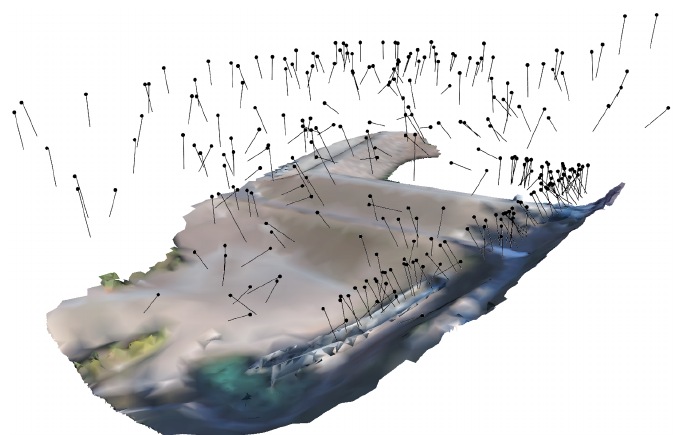
Figure 8. Final optimized camera position and orientations for the multi-scale flight.